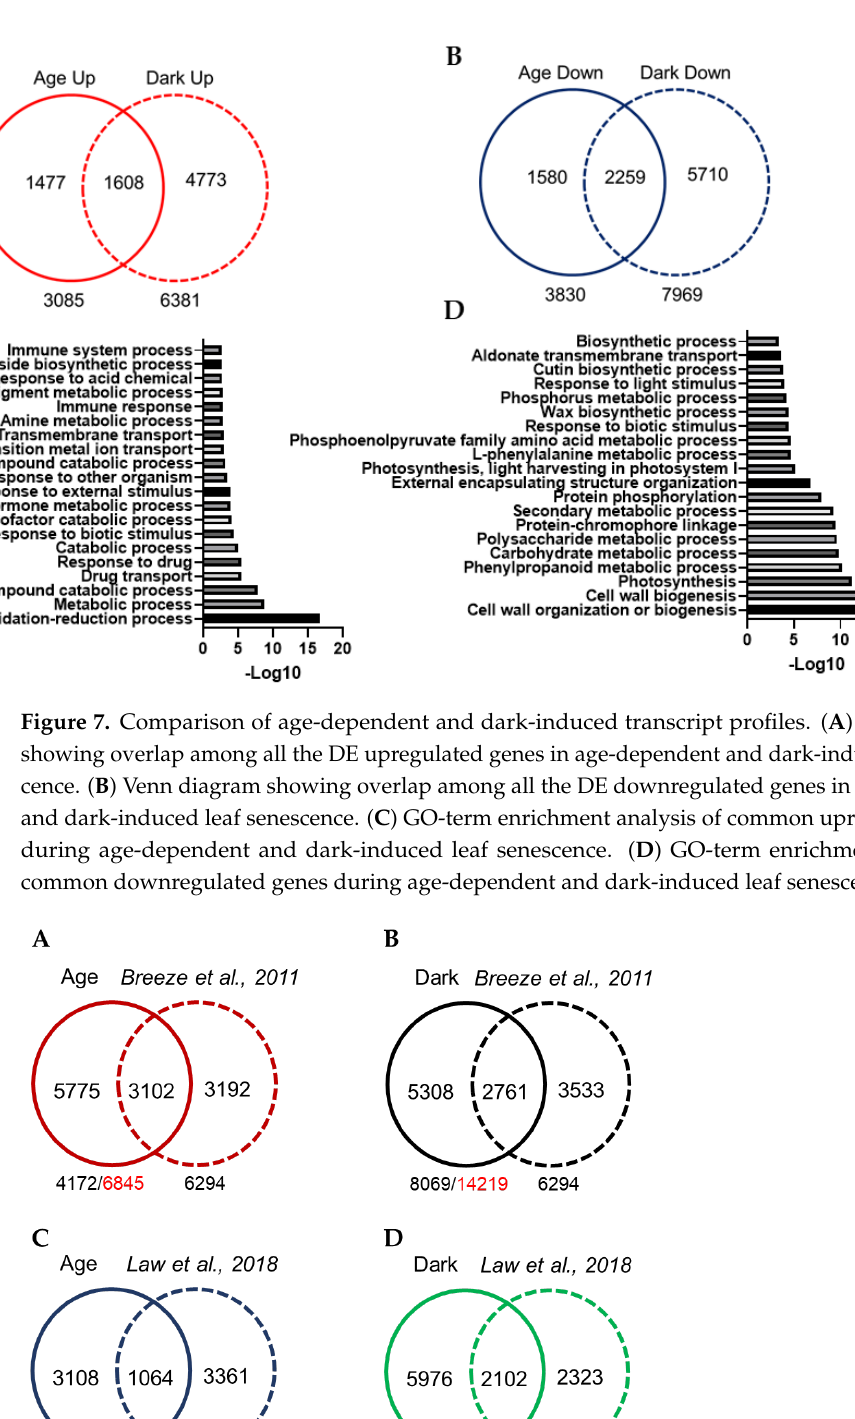
Figure 7. Comparison of age-dependent and dark-induced transcript profiles. ( A ) Venn diagram showing overlap among all the DE upregulated genes in age-dependent and dark-induced leaf se- nescence. ( B ) Venn diagram showing overlap among all the DE downregulated genes in age-de- pendent and dark-induced leaf senescence. ( C ) GO-term enrichment analysis of common upregu- lated genes during age-dependent and dark-induced leaf senescence. ( D ) GO-term enrichment anal- ysis of common downregulated genes during age-dependent and dark-induced leaf senescence.